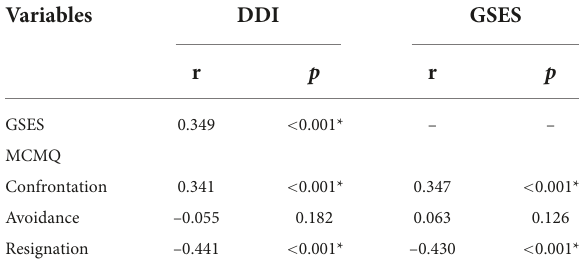
TABLE 2 Correlation among psychotypical characteristics of adolescents with depression before ( n =